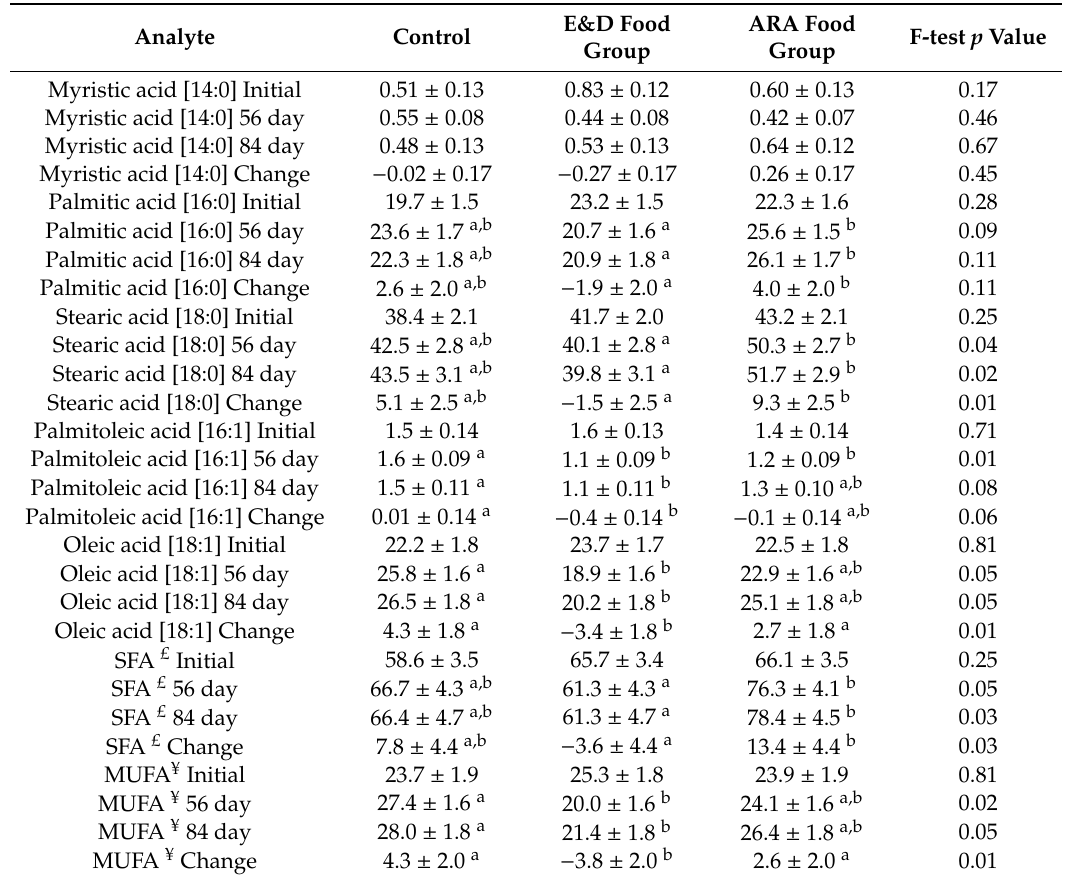
Table 4. Circulating concentration (mg / dL) of saturated and monounsaturated fatty acids from cats eating control food (COF), or test food 1 (E&DF) COF enhanced with EPA and DHA from fish oil, or test food 2 (ARAF) COF enhanced with arachidonic acid from chicken liver, at initial, 56 days, 84 days of test and change during the study (values are lsmeans ± standard